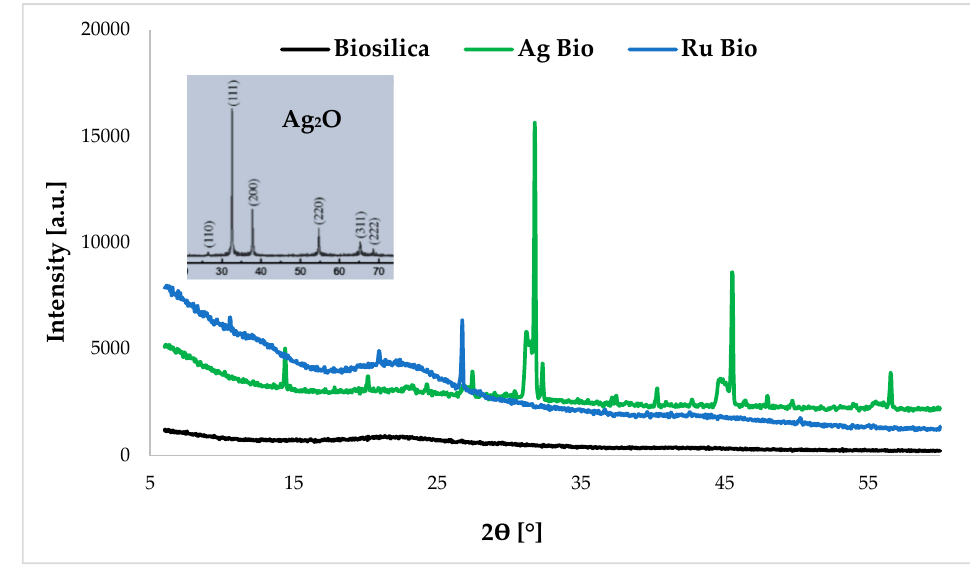
Figure 2. Diffractogram of porous materials based on diatom biosilica doped with silver or ruthenium ions in the wide-angle range.